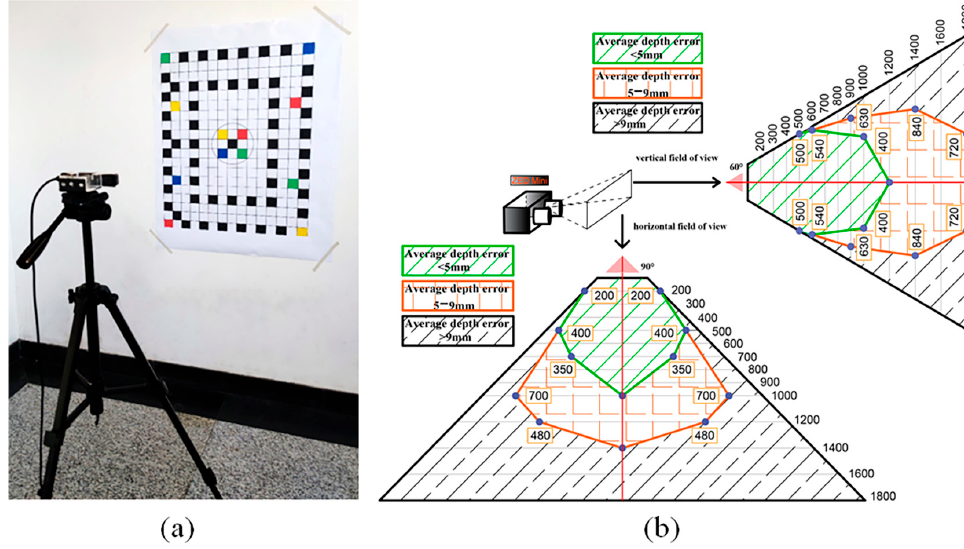
Figure 1. Depth measurement errors of the stereo camera. ( a ) Test setup; ( b ) Spatial distributions of measured depth errors. The numbers from 200 to 1800 are in millimeters.